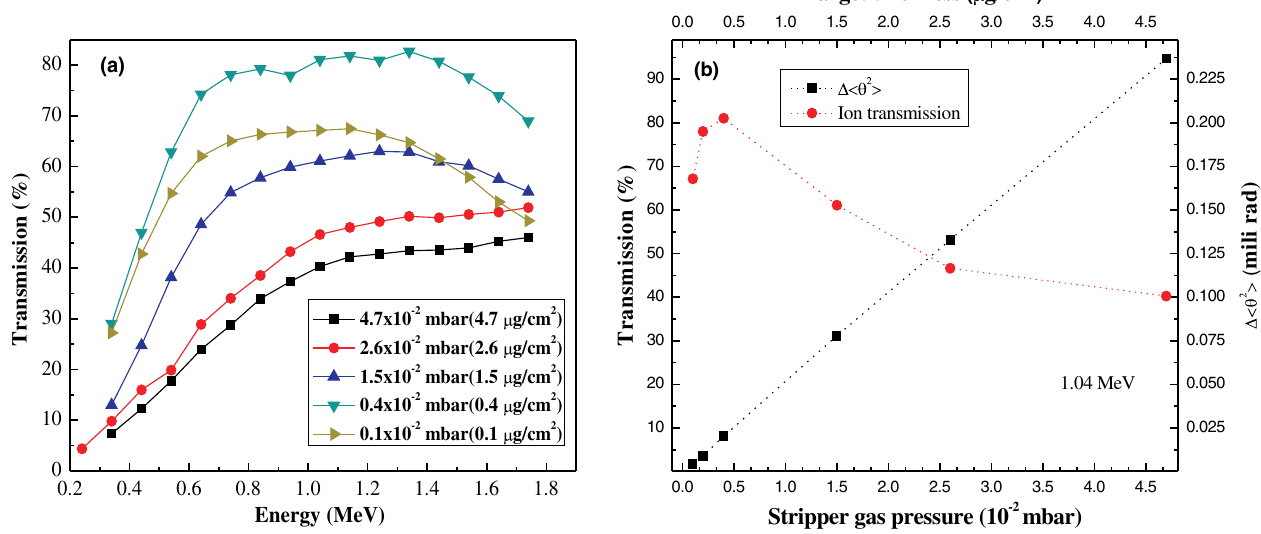
FIG. 4. (a) Variations of transmissions of the incident 12 C 1 (cid:1) ions with incident ion energy at different stripper gas pressures. (b) Variation of transmission, and change in mean square scattering angle ( (cid:1) h (cid:2) 2 i ) with stripper gas pressure at 1.04